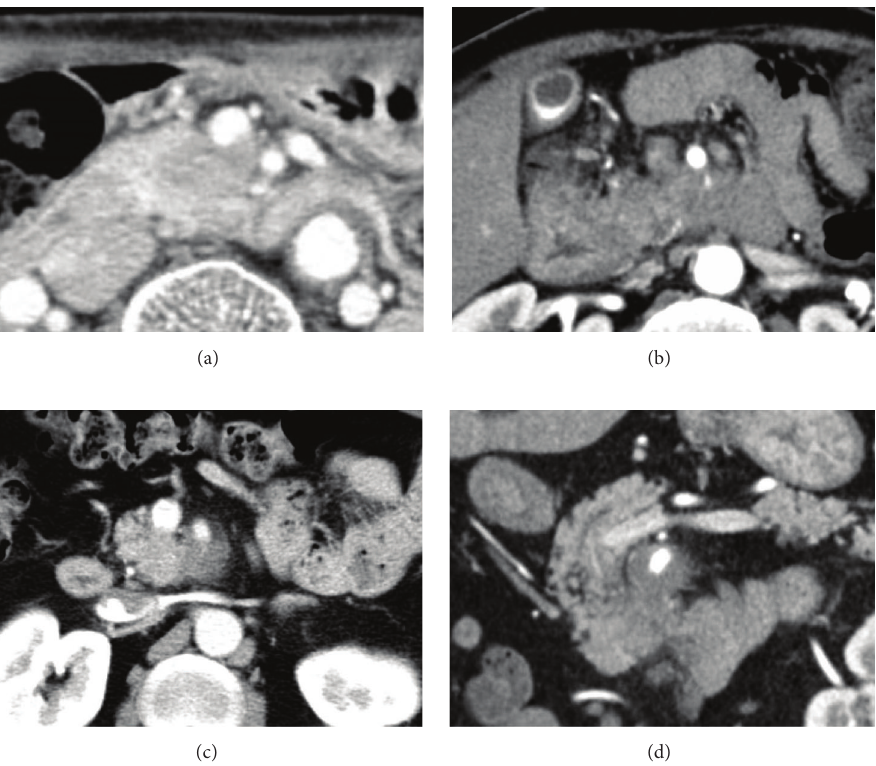
Figure 2: Representative computed tomography images of borderline resectable pancreatic cancer and locally advanced unresectable pancreatic cancer. (a), (b) Tumor in the pancreatic head slightly abutting the portal vein and invading less than half of the circumference of the superior mesenteric artery (borderline resectable pancreatic cancer). (c), (d) Tumor in the pancreatic head invading less than half the circumference of the superior mesenteric artery (locally advanced unresectable pancreatic cancer).